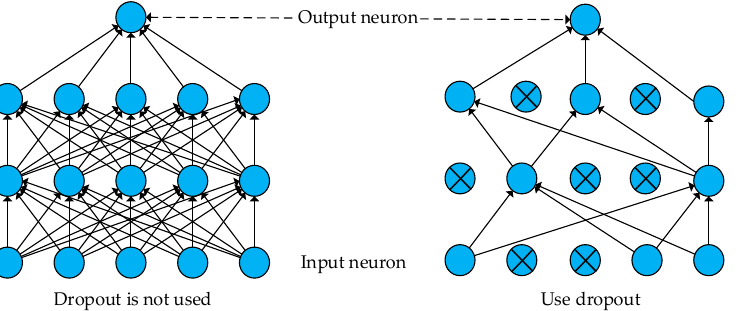
Figure 8. Neural network without dropout and neural network with dropout forward propagation.